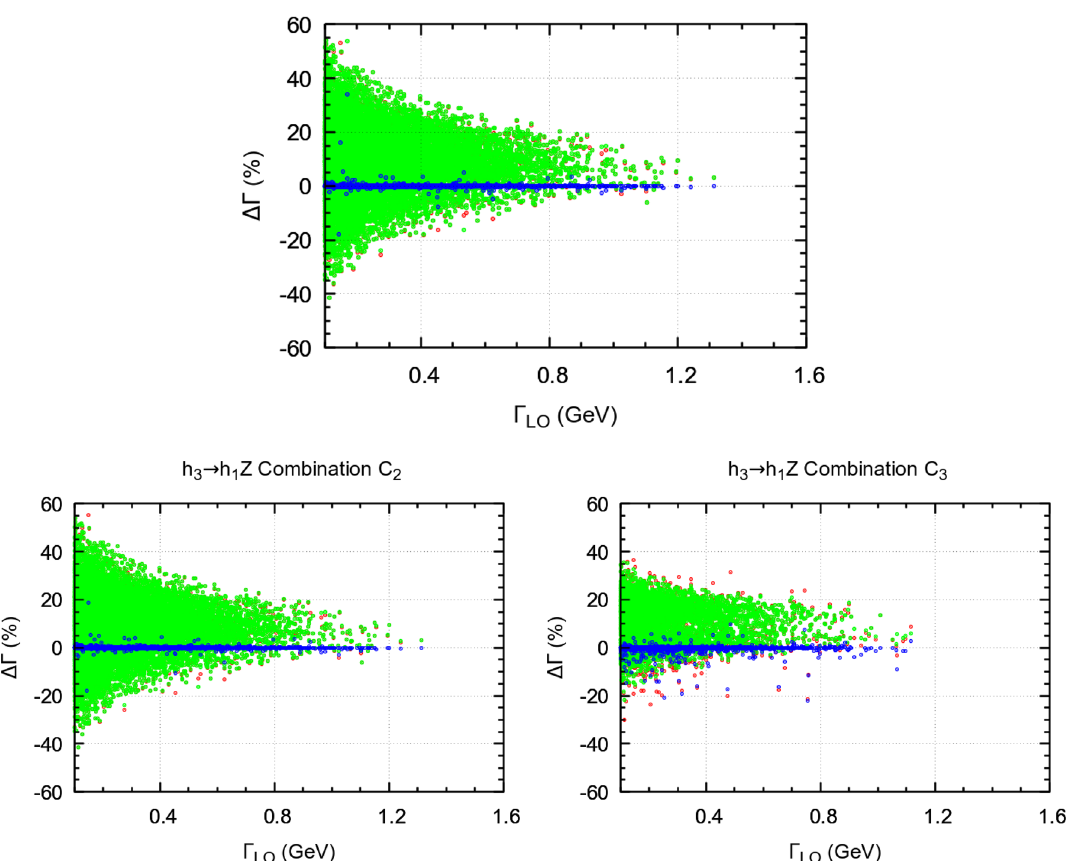
Figure 5. ∆Γ h in percentage against Γ LO , for the combinations C 1 (top), C 2 (bottom h 3 → h 1 Z 3 → h 1 Z left) and C 3 (bottom right). The cuts leading to the blue points in figure 3 were applied. Only the interval 0 . 1 GeV < Γ LO < 1 . 6 GeV is shown. In red, ∆Γ h ; in green, Γ mix / Γ LO ; h 3 → h 1 Z h 3 → h 1 Z h 3 → h 1 Z 3 → h 1 Z in blue, Γ m 3 / Γ LO . According to eq. (4.5), the red points are the sum of the green and the h 3 → h 1 Z h 3 → h 1 Z blue